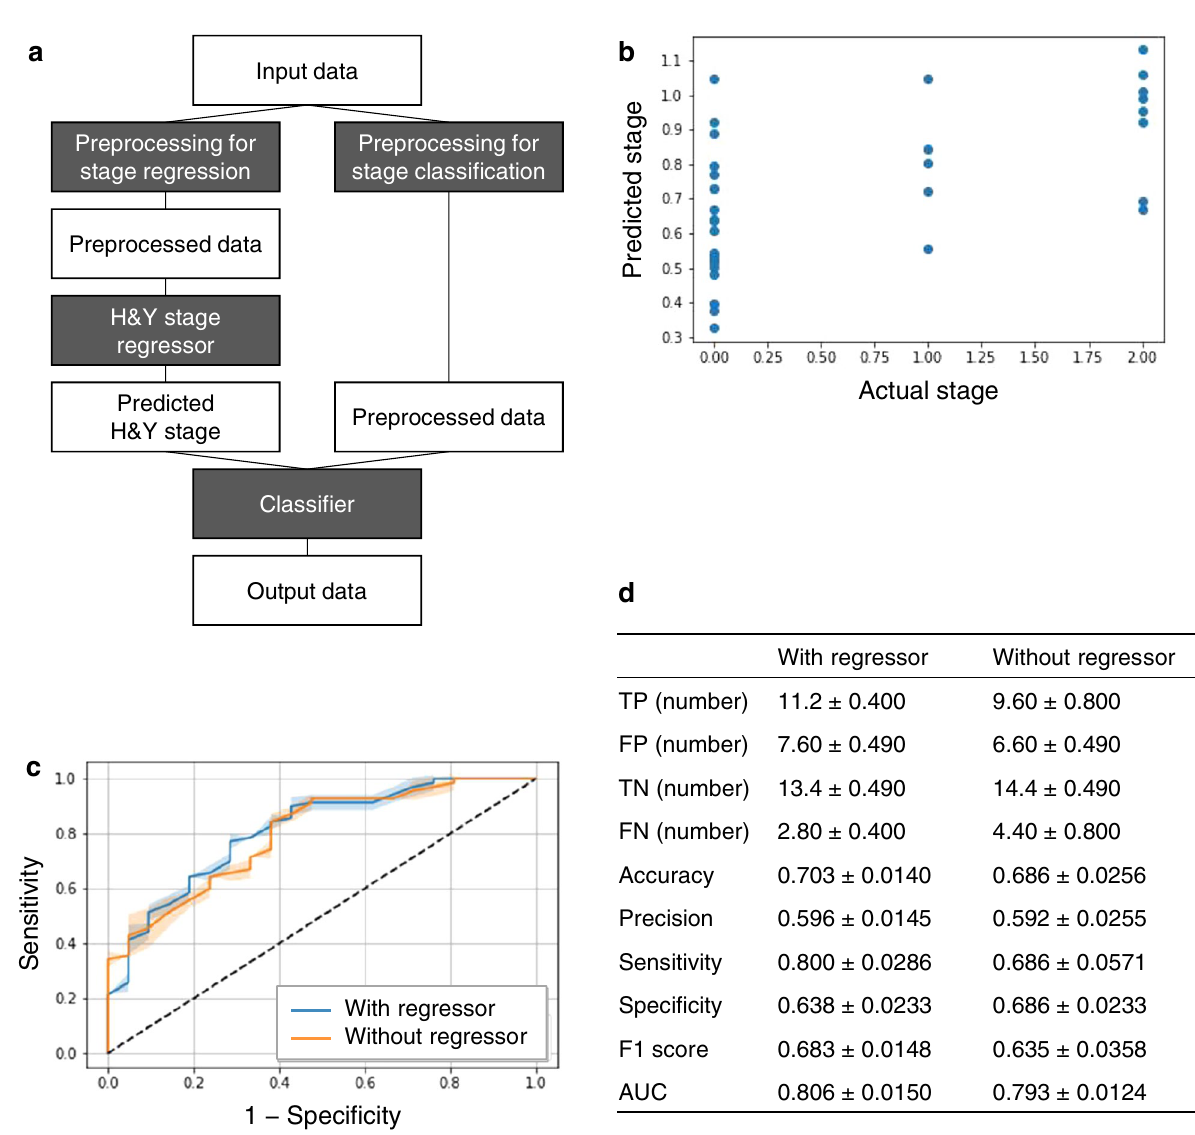
Figure 4. Discrimination model for Parkinson’s disease using machine learning with SSL-RNA profiles. ( a ) Discrimination pipeline. The rank normalized expression level, age, and sex were used as the input data. ( b ) Predicted H&Y stage with the regressor. Dots were plotted for each test sample showing the actual stage ( x -axis) vs. the predicted stage ( y -axis). ( c ) Receiver operating characteristic curve of the discrimination model. The graph shows 1 − specificity ( x -axis) vs. sensitivity ( y -axis) in the test samples. Lines and error bands represent the means and SDs of five receiver operating characteristic curves with different seeds. ( d ) Performance of the discrimination model. The performance was evaluated in the test samples. Each metric is shown as the mean and SD of the evaluation results of five trainings with different seeds. AUC area under the receiver operating characteristic curve, H&Y Hoehn and Yahr, FN false negative, FP false positive, TN true negative, TP true